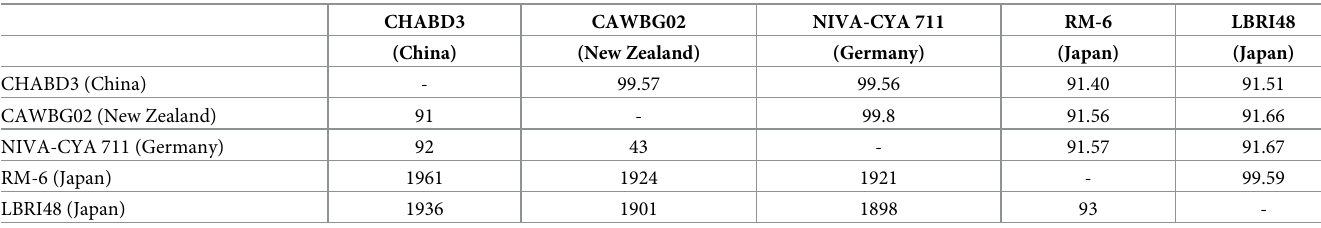
Table 2. Similarities of the ana gene cluster ( anaA-anaG ) based on 22,802 base pairs for Cuspidothrixissatschenko i strain NIVA-CYA 711 (LT984882; Germany), CAWBG02 (LT984883; New Zealand), CHABD3 (KM245025; China): LBRI48 (KM245023; Japan) and RM-6 (KM245024; Japan). The values in the upper right trian- gle are the percent identities between a pair of sequences. The values in the lower left triangle are the numbers of dissimilar